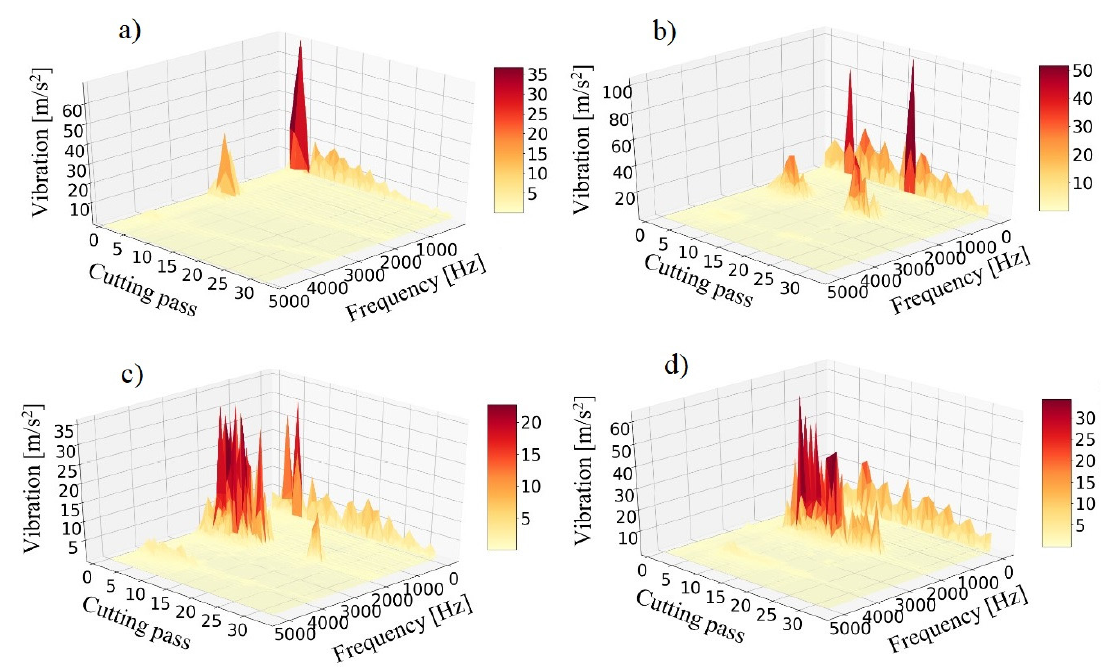
Figure 7. FFT of vibration signal of samples during machining. ( a ) TP10. ( b ) TP08. ( c ) TP04. ( d )